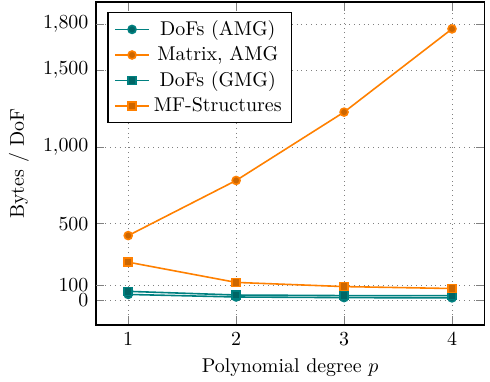
Figure 8. Storage requirements in bytes per dof for varying polynomial